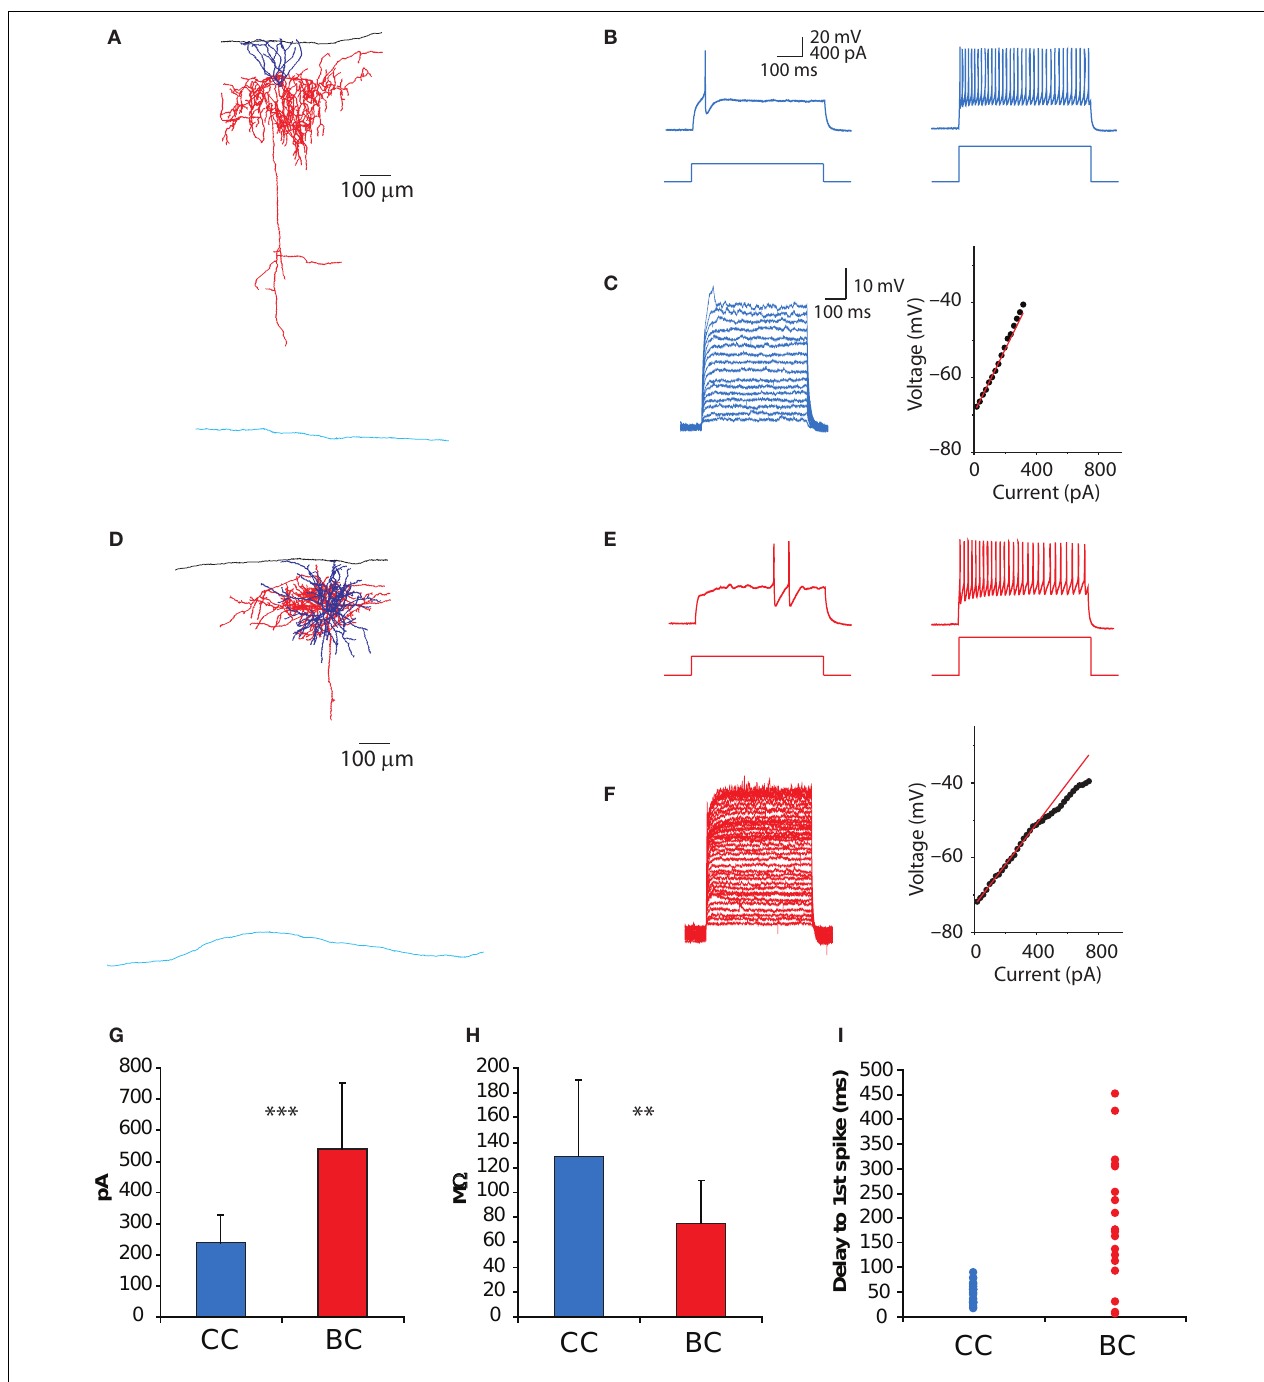
FIGURE 2 | Electrophysiological characterization of Nkx2 chandelier and basket cells. (A) Camera lucida reconstruction of the chandelier cell recorded from in (B,C) . Blue lines indicate dendrites, red lines indicate axon, black lines show pial surface and light blue lines white matter border. (B) Threshold ( left ) and